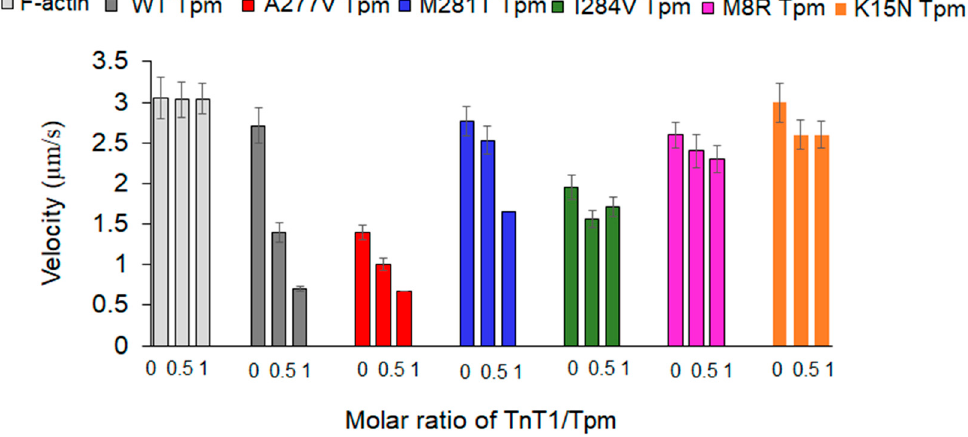
Figure 5. Effect of TnT1 on the sliding velocity of the F-actin-Tpm filaments, containing Tpm with cardiomyopathy mutations, over myosin in the in vitro motility assay.